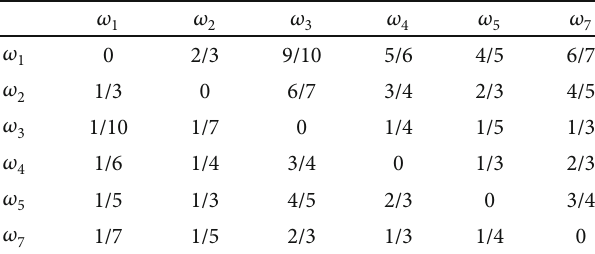
Table 3: Weight list after conversion.